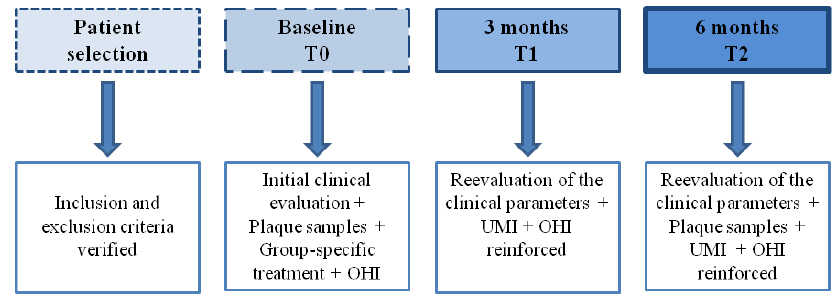
Figure 1. Treatment timeline.